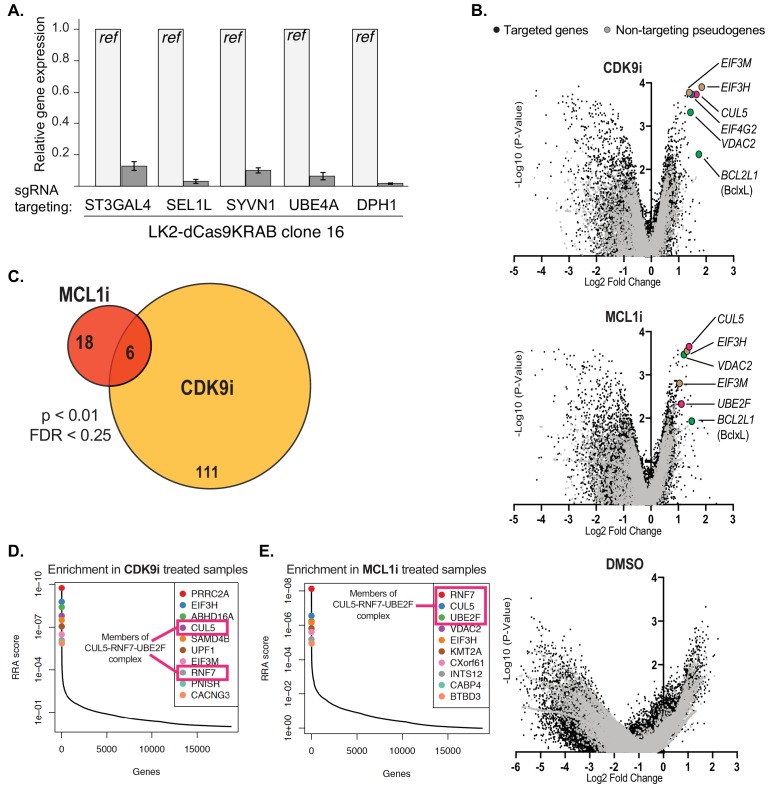
Performing the genome-wide CRISPRi screens and analysis of results.(A) Bar graph showing knockdown of five genes by qRT-PCR to confirm functionality of the dCas9-KRAB CRISPRi construct in an isolated clone of LK2 cells. (B) Volcano plots (as in Figure 2B) showing significantly enriched and depleted genes when treated with CDK9i (top), MCL1 (middle) and DMSO (bottom). Black dots indicate targeted genes. Gray dots indicate negative control pseudogenes with non-targeting guides. Highlighted points of different colors show genes with significant fold changes with annotated roles in apoptosis (green), factors of the CUL5-RNF7-UBE2F ubiquitin complex (magenta), and members of the eIF3 complex (beige). (C) Venn diagram of overlapping hits between CDK9i and MCL1i screens as determined by MAGeCK analysis using a threshold of p<0.01 and FDR < 0.25. Number of hits listed in circles. (D + E) Relative sgRNA enrichment was also determined by the MAGeCK analysis pipeline. Top 10 targeted genes following CDK9i and MCL1i treatment are shown in (D) and (E), respectively. sgRNAs targeting members of the CUL5-RNF7-UBE2F complex (outlined in magenta box) were once again identified as enriched and were amongst the most significant hits.